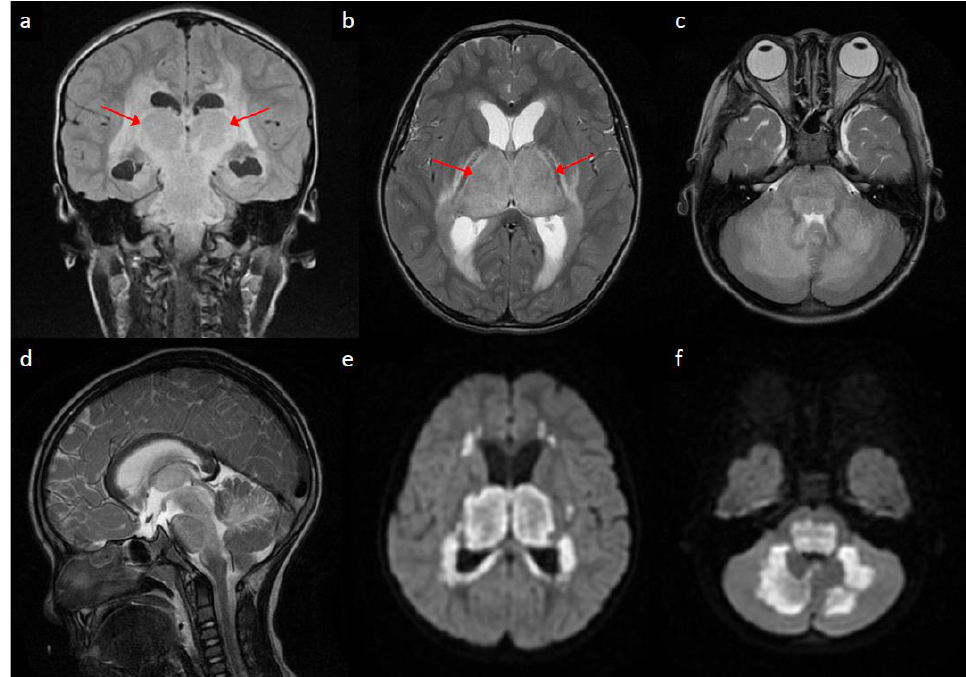
Figure 1. Brain magnetic resonance imaging of the patient: ( a ) coronal view of T2 fluid-attenuated inversion recovery sequence showing hyperintense signals in bilateral thalami (arrows) and periventricular regions; ( b , c ) Axial view of T2-weighted sequences at the level of basal ganglia/thalami (arrows) and pons/cerebellum, respectively, showing relatively symmetric hyperintense signals in bilateral thalamic, periventricular, pontine and cerebellar regions; ( d ) sagittal view of T2-weighted sequence showing hyperintense signal changes in brainstem and cerebellum; ( e , f ) axial view of diffusion-weighted imaging at the levels corresponding to ( b , c ), respectively, showing bright signals in bilateral thalamic, periventricular, pontine and cerebellar regions.